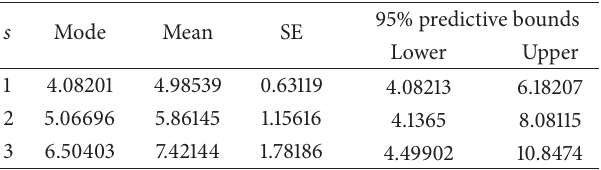
Table 10: The summary of the one sample predictive densities for real data set when 𝑟 = 20